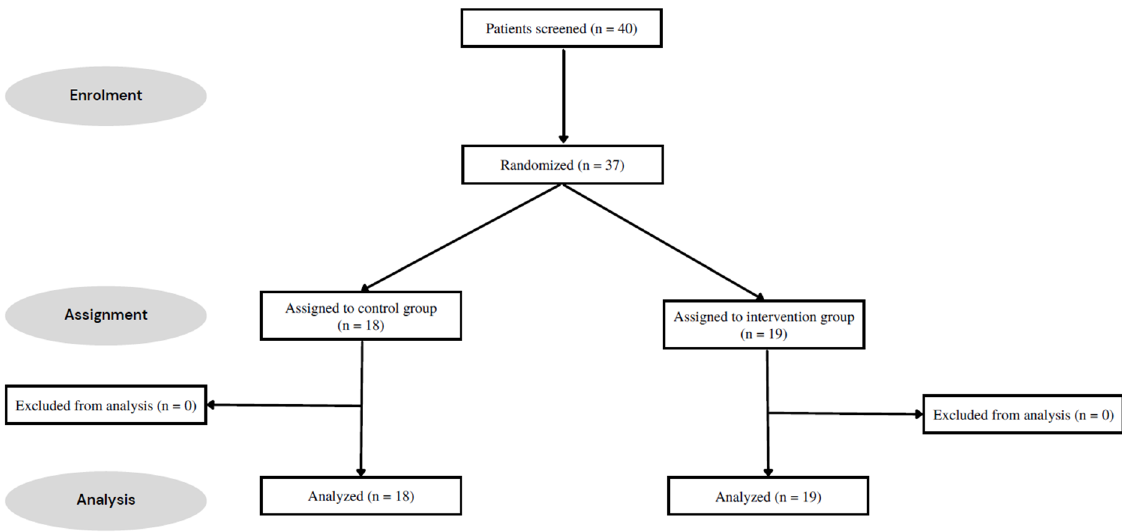
Figure 1. Consort flow chart. Table 1. Demographics and clinical parameters at baseline.